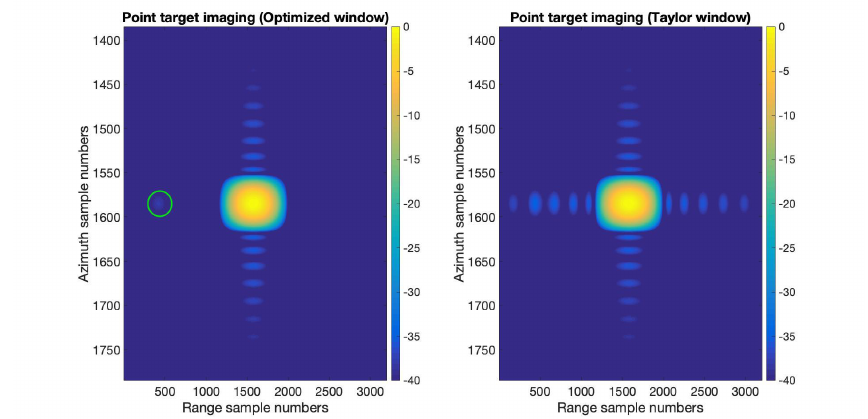
Figure 9. The images of the interpolated results (after upsampling) of the optimized window and the Taylor window (¯ n = 6,PSLR = − 35 dB).